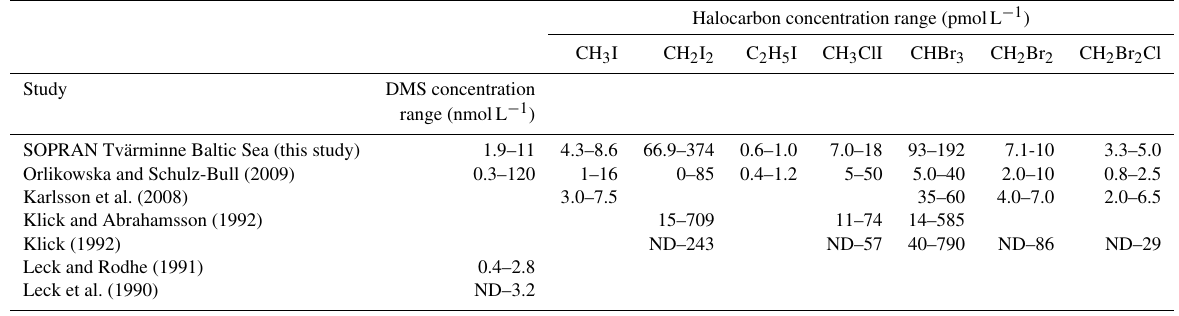
Table 5. Concentration ranges of trace gases measured in the Baltic Sea compared to concentrations measured in the